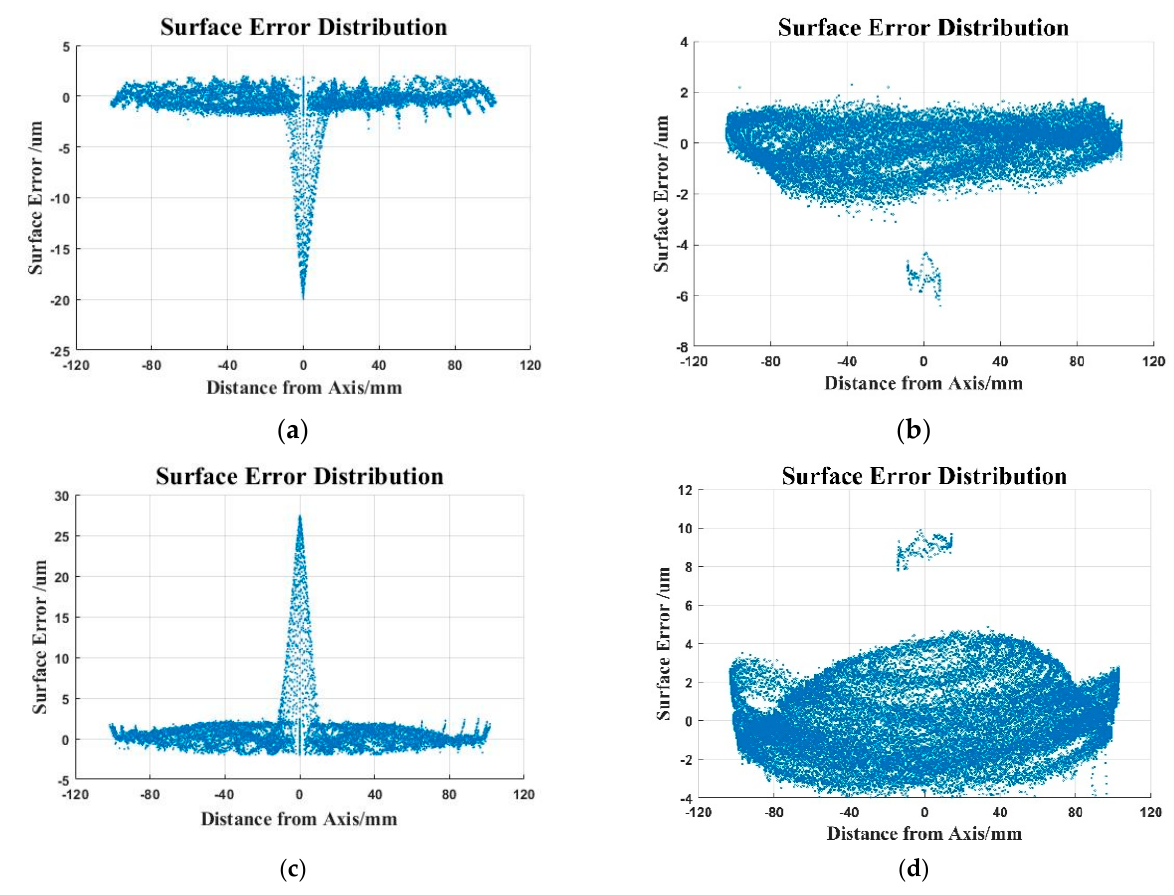
Figure 10. The surface error distribution: ( a ) Surface error distribution of the outer surface (the meridian trajectory); ( b ) surface error distribution of the outer surface (the concentric trajectory); ( c ) surface error distribution of the inner surface (the meridian trajectory); ( d ) surface error distribution of the inner surface (the concentric trajectory).